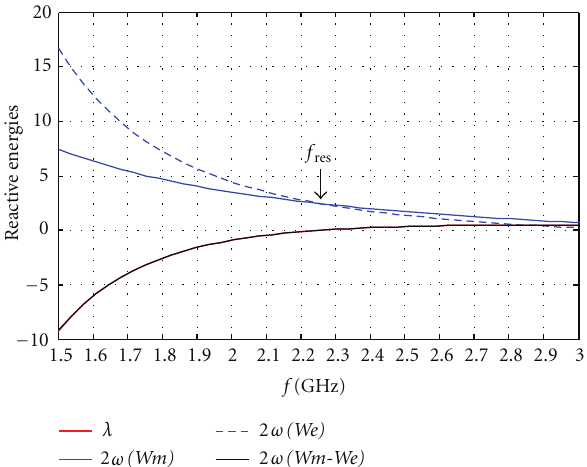
Figure 5: Reactive energies and their di ff erences for an R50 × 30 patch at height of 25mm.